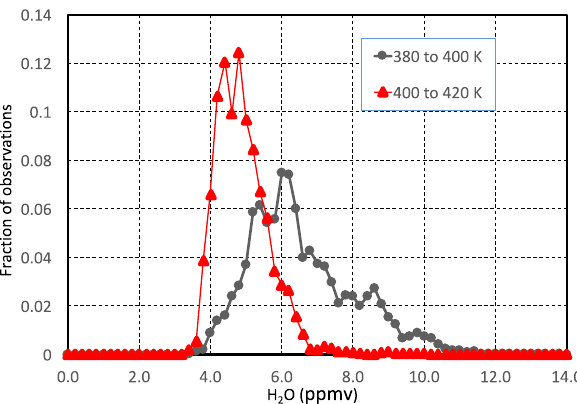
2 Figure 3. The distribution of Aura MLS v4.2 100hPa H 2 O over CONUS (blue shaded box in insert), corresponding to approx- imately 17km of altitude. The two histograms for July–August 2013 (blue asterisks and trace) and the previous nine-summer MLS record, for July–August 2004 through 2012 (red circles and trace), indicate that 2013 was drier than average. The threshold for MLS- detected “enhanced water vapor” (thick black vertical line) is set at 8ppmv, the same as in Schwartz et al. (2013), to exclude the larger population of measurements at 6 to 8ppmv of water vapor that may have other